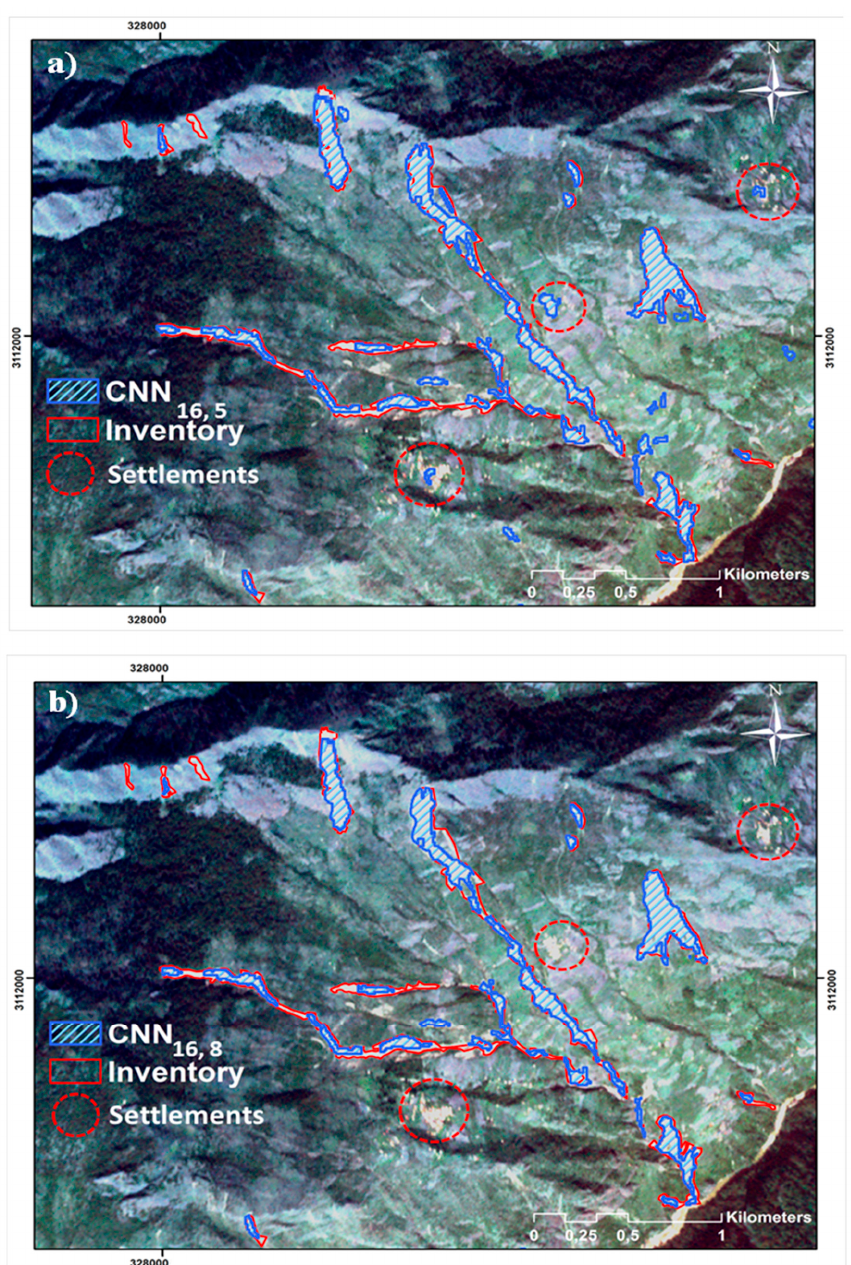
Figure 11. Enlarged maps of ( a ) CNN (16,5) and ( b ) CNN (16,8).